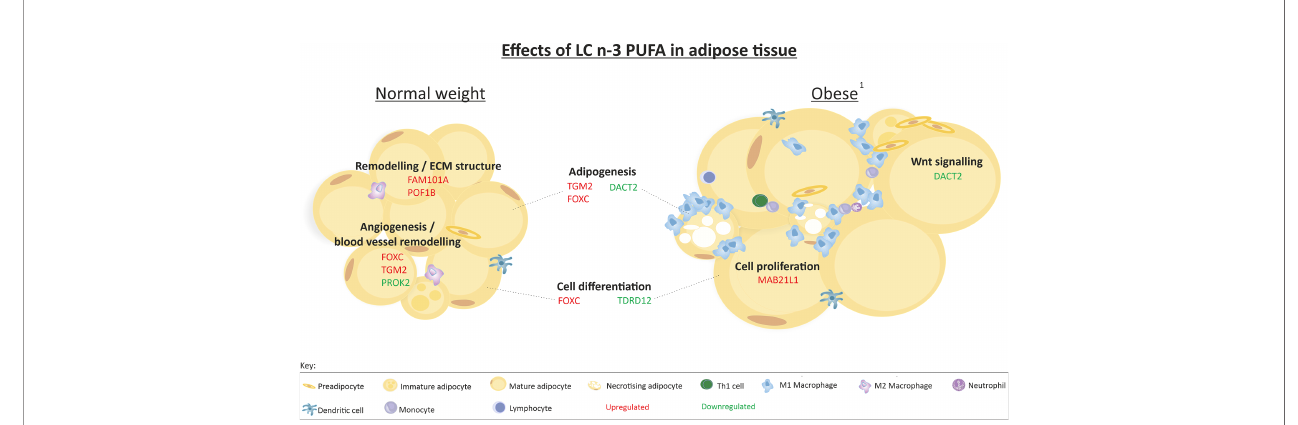
FIGURE 9 | Summary of the effects of 12-week LC n-3 PUFA intervention on scWAT in normal weight individuals and individuals living with obesity. 1 Obesity in which metabolic complications are yet to manifest. Indication of upregulation or downregulation of mRNA expression is the expression at week-12 in comparison to week-0 in each group of